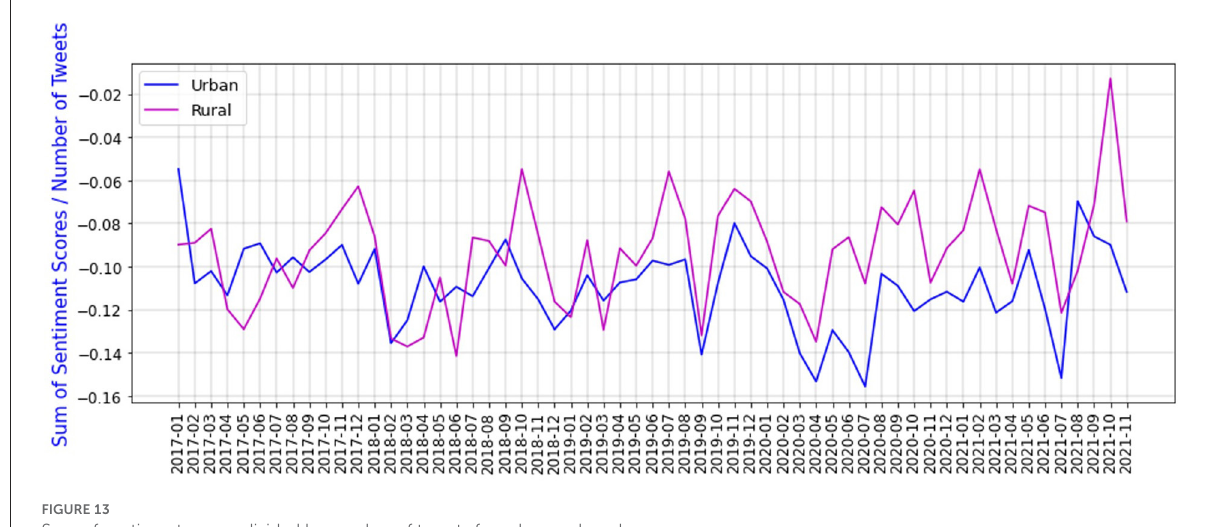
FIGURE13 Sum of sentiment scores divided by number of tweets for urban and rural